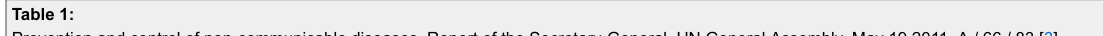
Table 1: Prevention and control of non-communicable diseases. Report of the Secretary-General, UN General Assembly, May 19 2011, A / 66 / 83 [3]. It is recommended that Member States: ‒ Include prevention and control of non-communicable diseases among priorities in national health strategies and plans; ‒ Implement cost-effective population-wide interventions, including through regulatory and legislative actions, for the non-communicable disease related risk factors of tobacco use, unhealthy diet, lack of physical activity and harmful alcohol use; ‒ Strengthen national information systems by implementing a surveillance framework that monitors key risk factors and determinants, morbidity and mortality and health- system capacity. Set standardised national targets and indicators to assess the progress made in addressing non-communicable